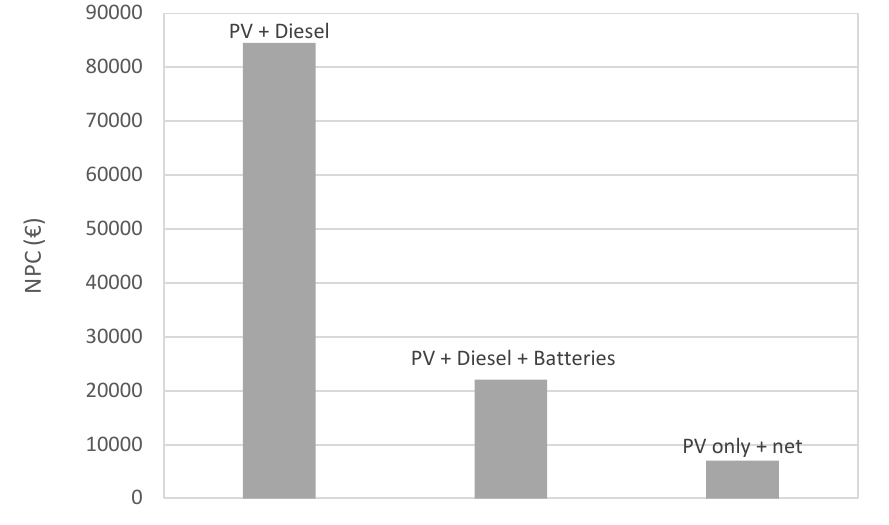
Figure 13. NPC of the different schemes. All cases represented.